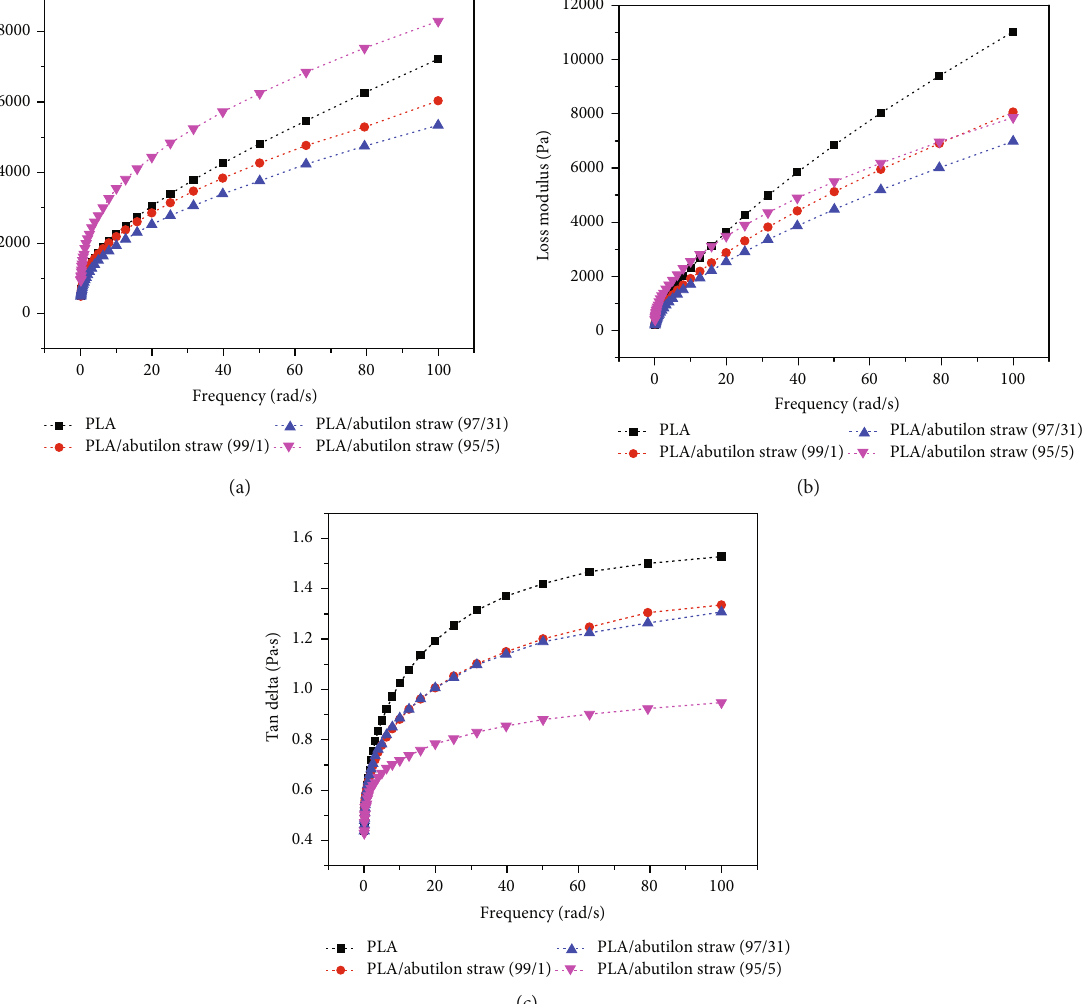
Figure 5: Rheological properties: (a) storage modulus; (b) loss modulus; (c) tan delta of PLA and PLA/abutilon straw